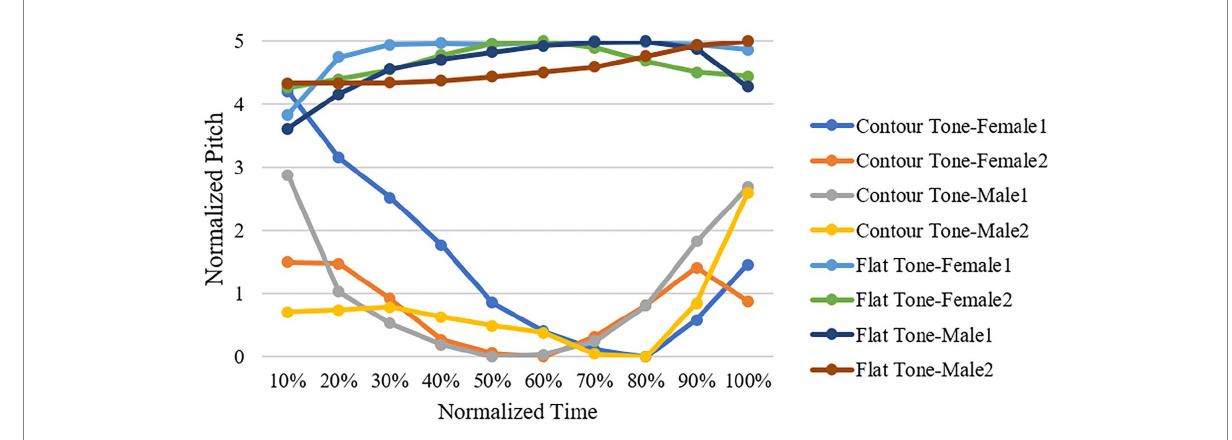
FIGURE 1 Four speakers neutral-intending expression of vowel /a/ with contour tone and flat tone normalized in a five-point